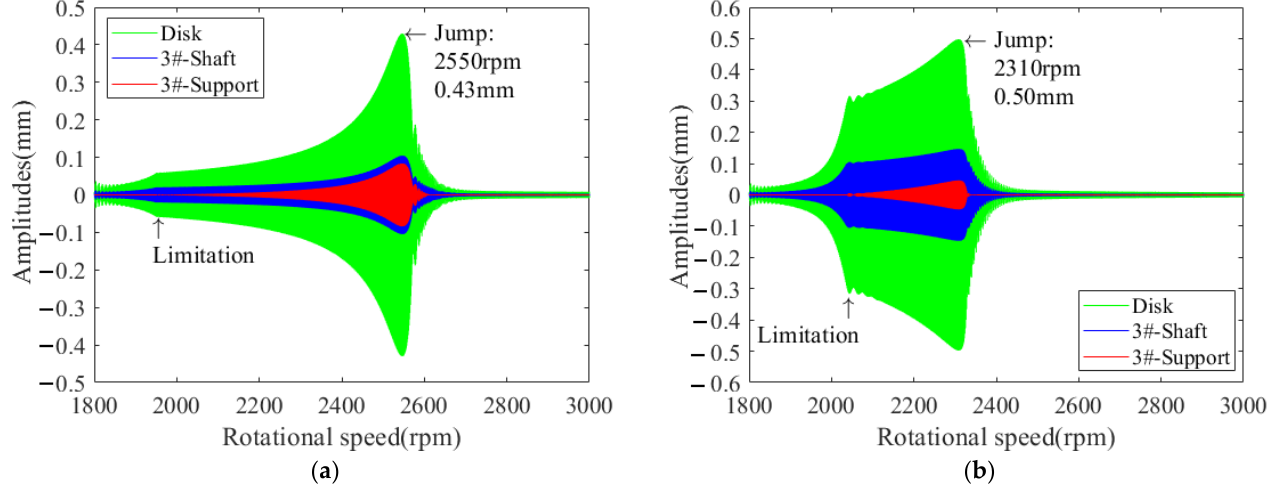
Figure 23. Continuous sweep response of the system near the first critical speed: ( a ) small clearance: 0.02 mm; ( b ) large clearance: 0.1 mm.